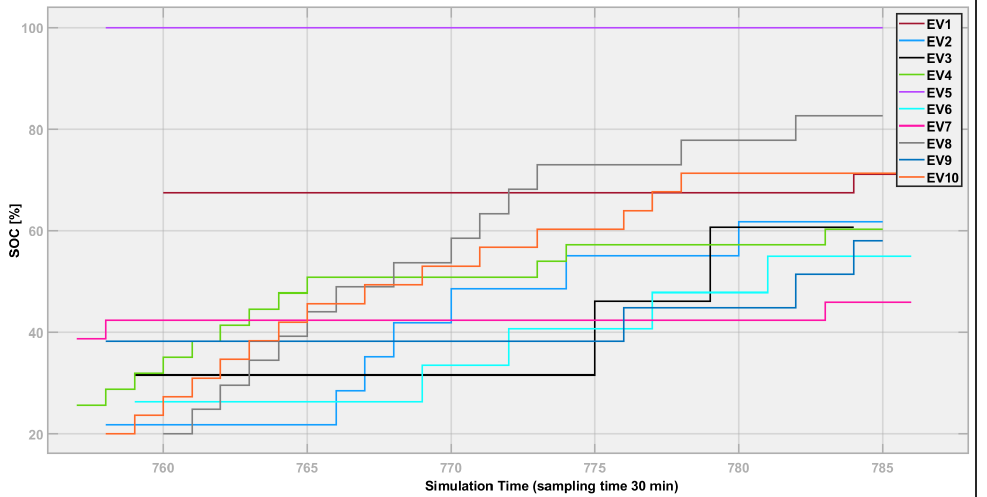
Figure 11. Extract from a simulation depicting the behavior of EV1, EV2 and EV3 as they are stopped until more urgent minimum requirements are met by other vehicles, such as